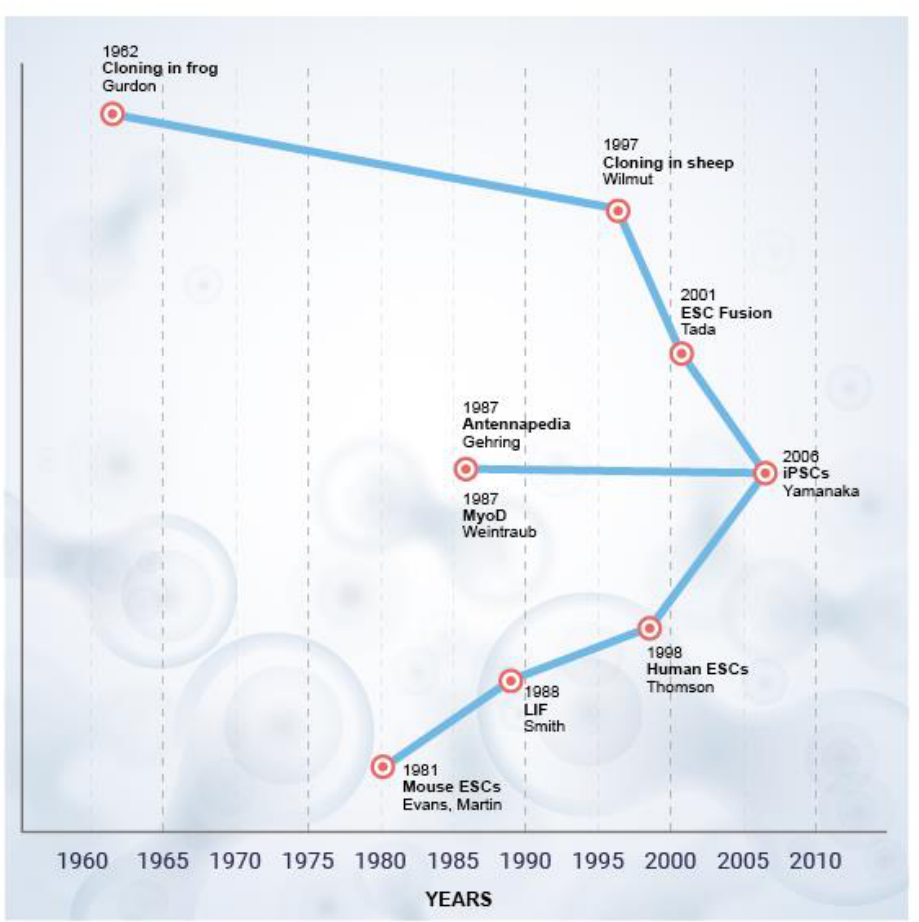
Figure 1. Pictorial presentation of the evolution of iPSC in 2006 from the past years of research on cloning and embryonic stem cells. cloning and embryonic stem